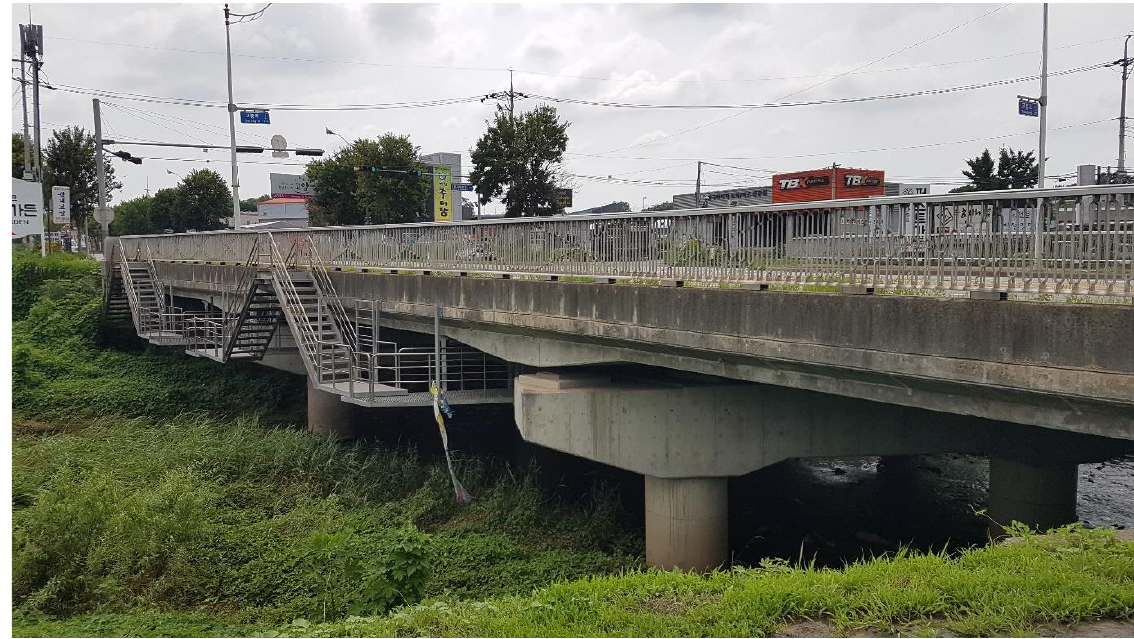
Figure 1. Seolmun Bridge (RC slab bridge).